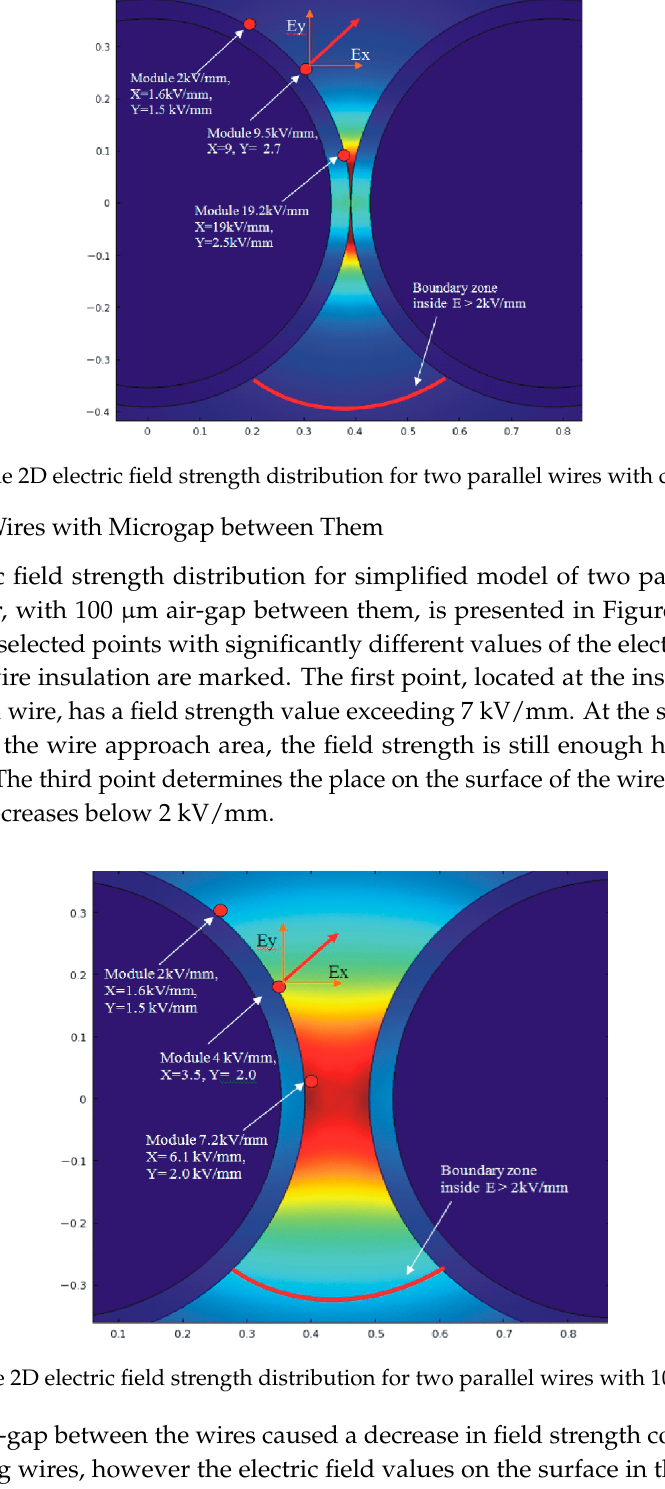
Figure 13. The 2D electric field strength distribution for two parallel wires with 100 μ m air ‐ gap.